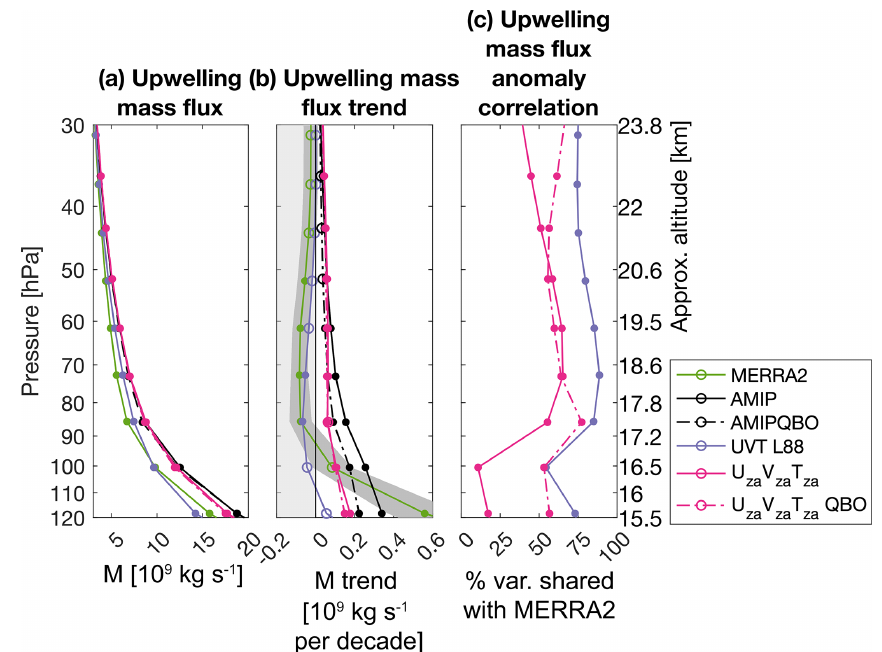
Figure 12. Climatological (a) upwelling mass flux, (b) upwelling mass flux trend, and (c) anomaly correlation with MERRA2. Shading and symbols in (a) and (b) as in Figs. 1 and 3, respectively. U za V za T za QBO is a U za V za T za simulation with zonal-mean zonal wind (QBO) nudging in the tropical